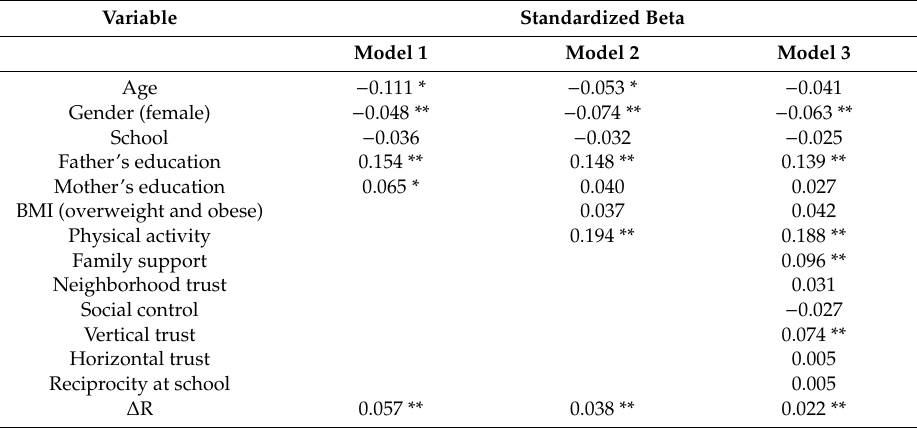
Table 2. Predictors of better adherence to a Mediterranean diet among Lithuanian high school students (hierarchical linear